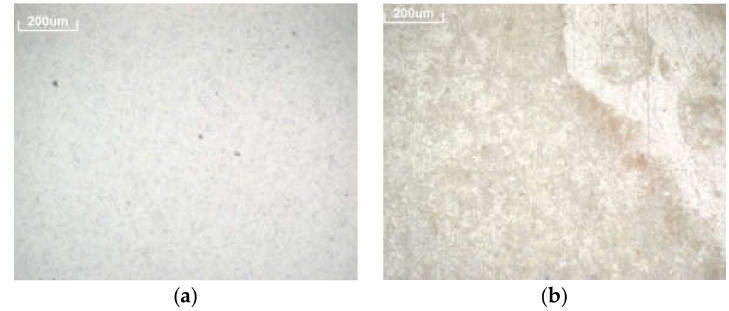
Figure 8. Paint layer of sample before ( a ) and after ( b ) the temperature cycling with Ouarzazate sand.